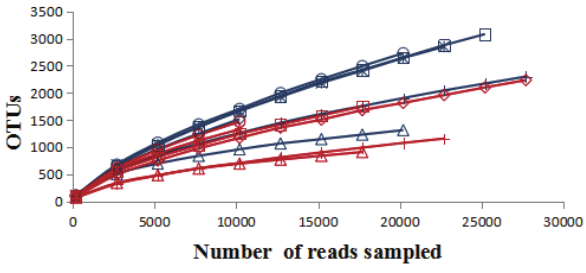
Figure 1. The rarefaction analysis was conducted at 97% sequence identity, and each curve represented one individual rumen sample of goats (n = 12). The blue curves: individuals fed at a completed feed (CF) diet; the red curves: individuals fed at all forage (AF) diet.